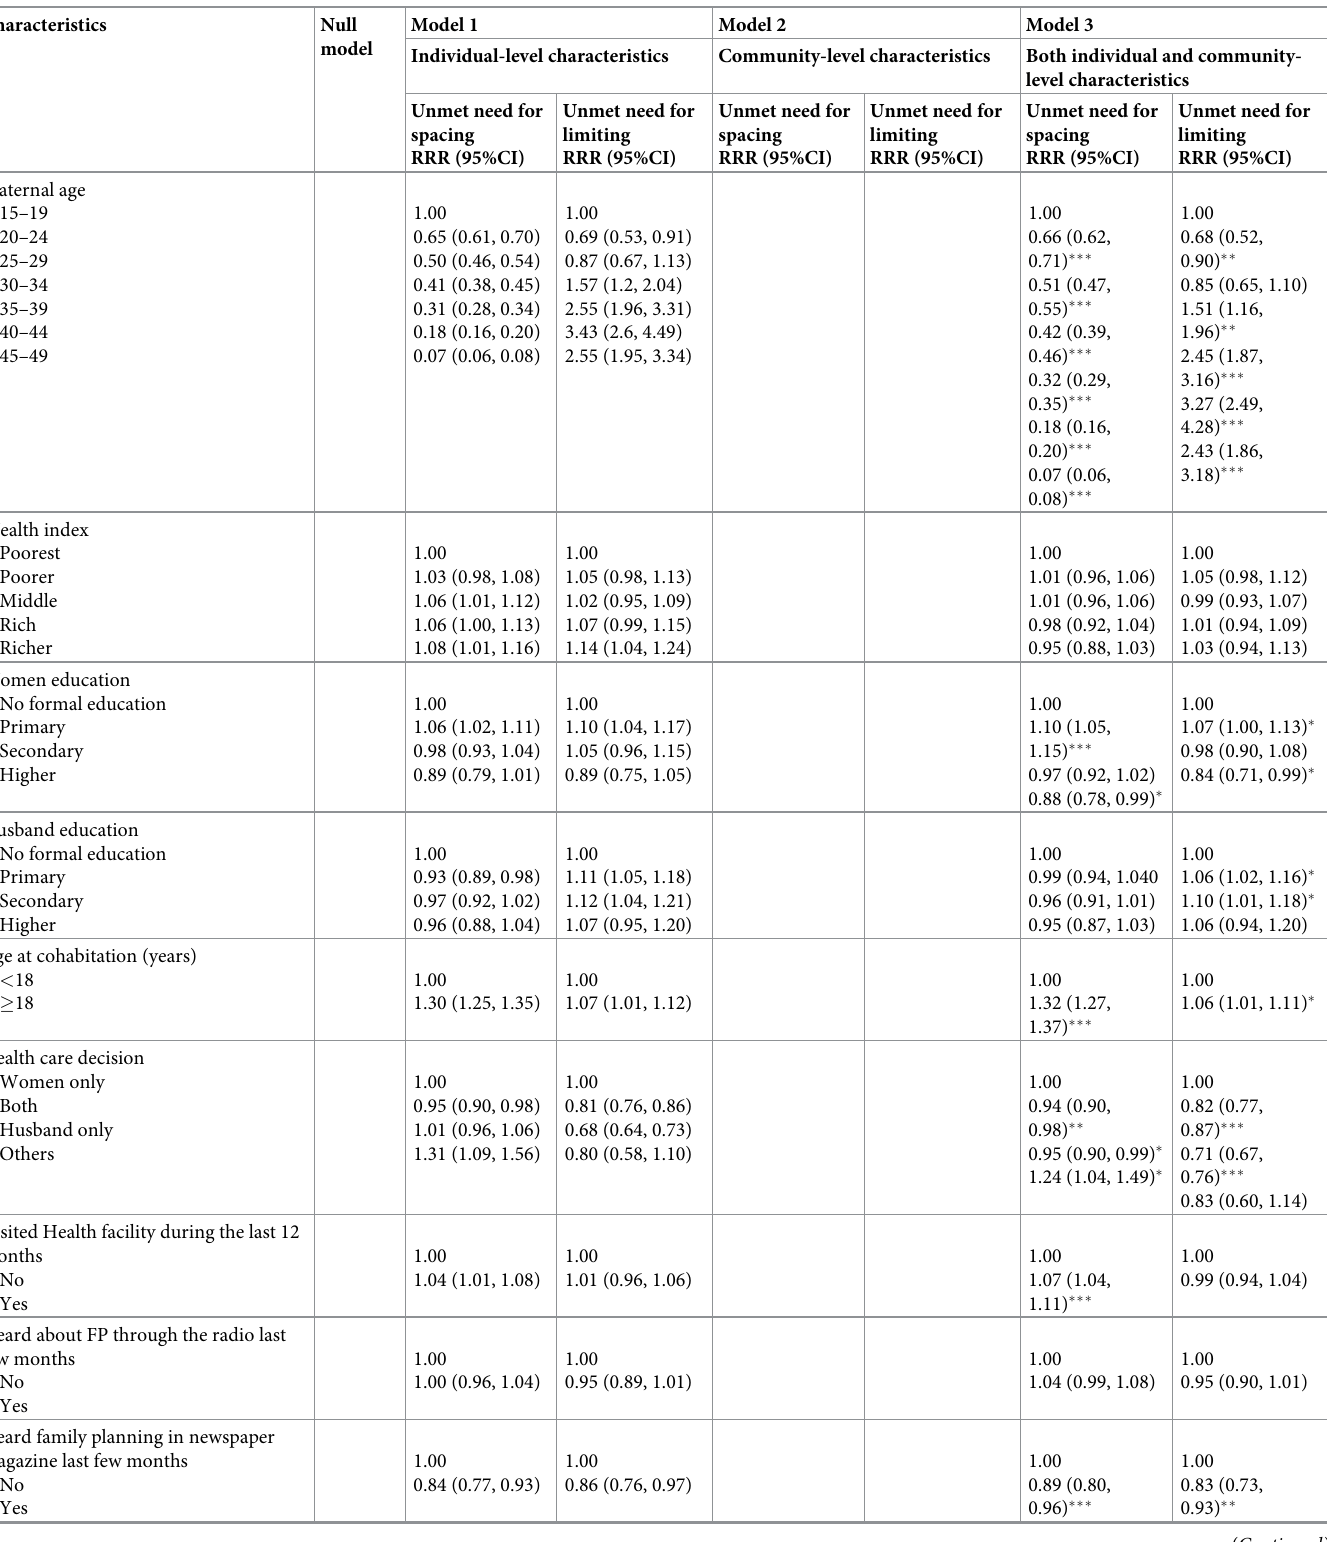
Table 3. Multilevel multinomial logistic regression analysis in assessing the factors associated with unmet need for family planning for (both spacing and limiting).